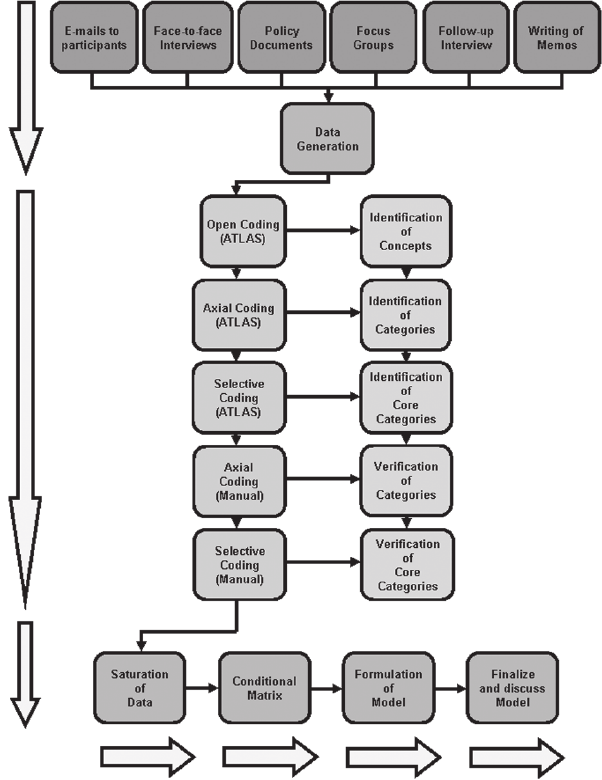
Figure1: Implementing the grounded theory